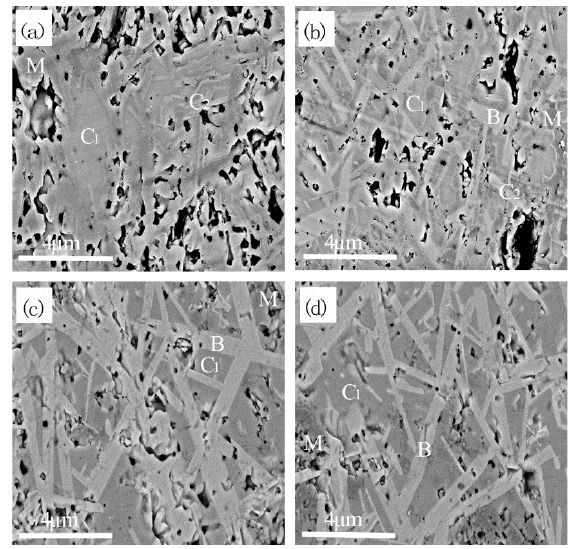
Figure 3. BSE images of the microstructures of the different samples after heating at 1600 °C for 2 h in air (M: MA; C 1 : CA 2 ; C 2 : CA 6 ; B: BAM). ( a ) Without BaO; ( b ) 2 wt. % BaO; ( c ) 4 wt. % BaO; ( d ) 6 wt. % BaO.